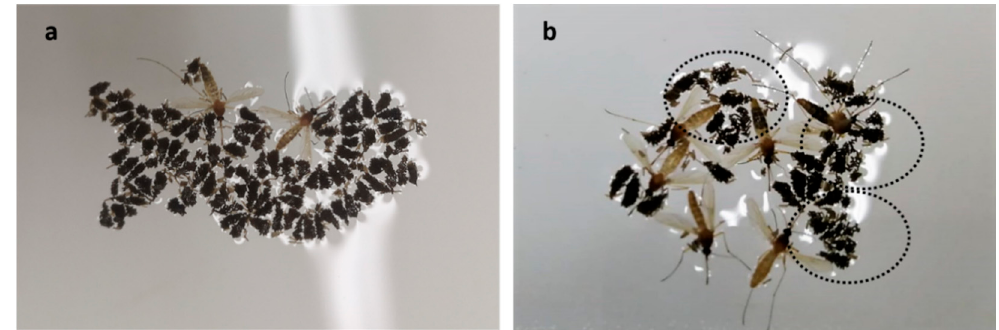
Figure 6. Egg rafts produced by Cx. pipiens in the ( a ) untreated control group and ( b ) the group exposed to the 0.8 mg/h prallethrin dose. In ( b ), the poorly assembled egg rafts have been circled to make them easier to identify.